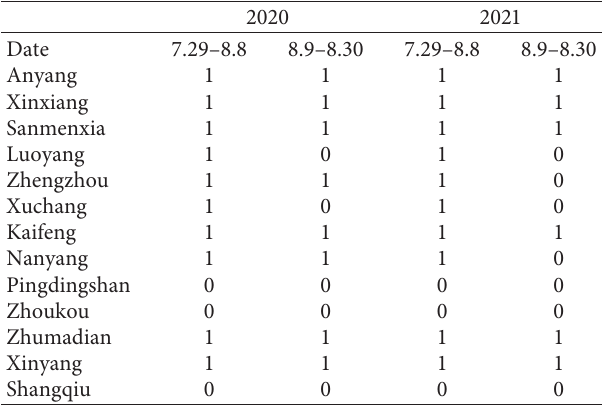
Table 2: Prediction of the occurrence of continuous rain disasters in 13 cities of Henan